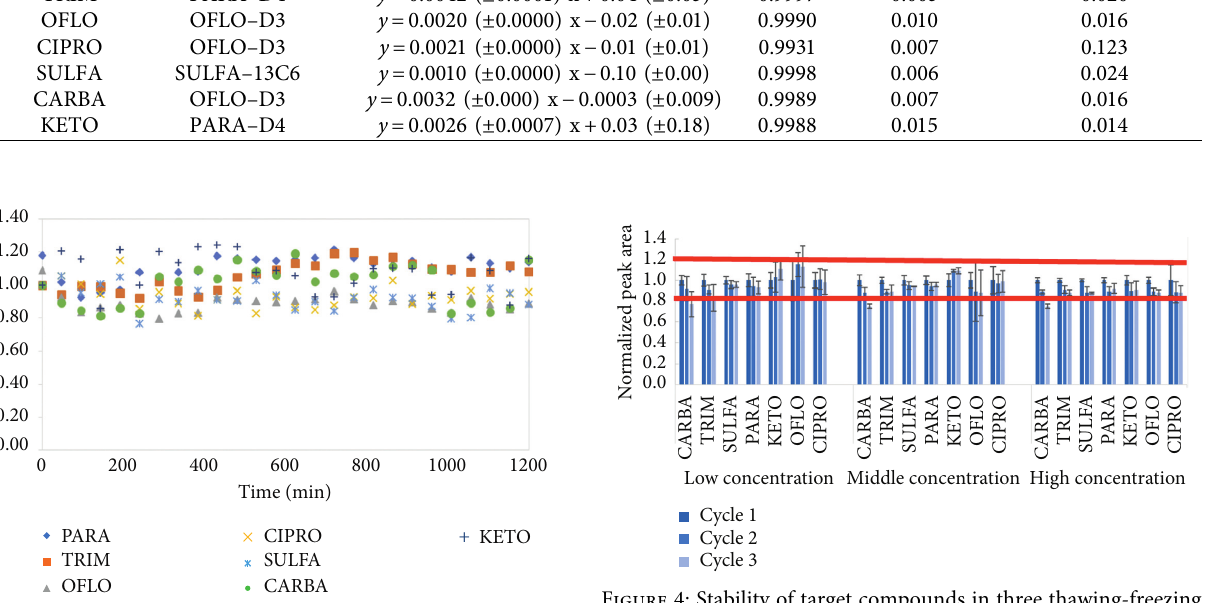
Figure 3: Stability of the analytical signal of all target compounds for 20 hours of